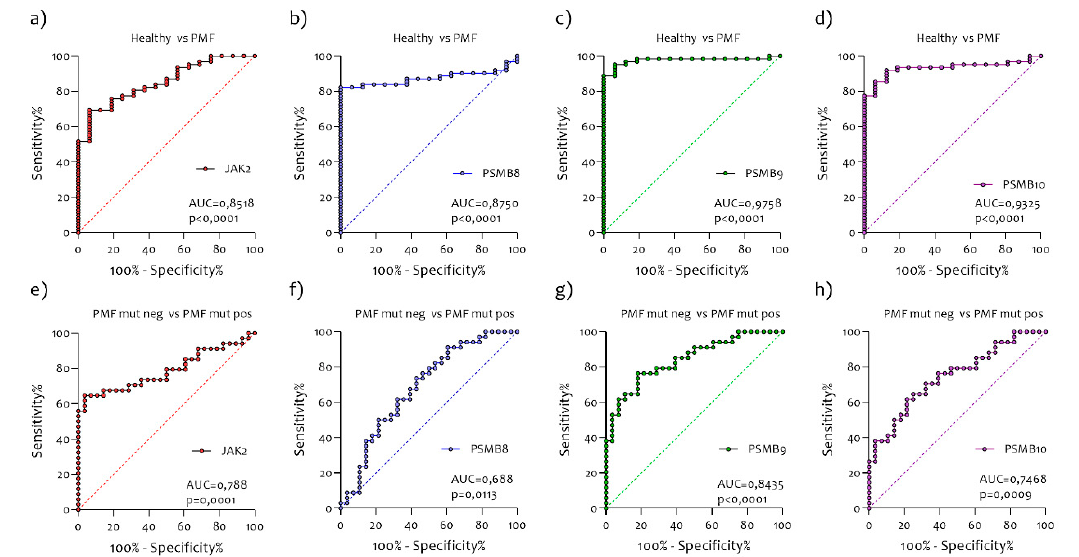
Figure 7. Diagnostic accuracy of JAK2 ( a , e ), PSMB8 ( b , f ), PSMB9 ( c , g ), and PSMB10 ( d , h ) mRNA for PMF patients. For single predictors, PSMB9 (c) had the highest accuracy, followed by PSMB10 (d) and PSMB8 (b). For PMF wild-type versus PMF mutated, PSMB9 (g) is a significant individual predictor.